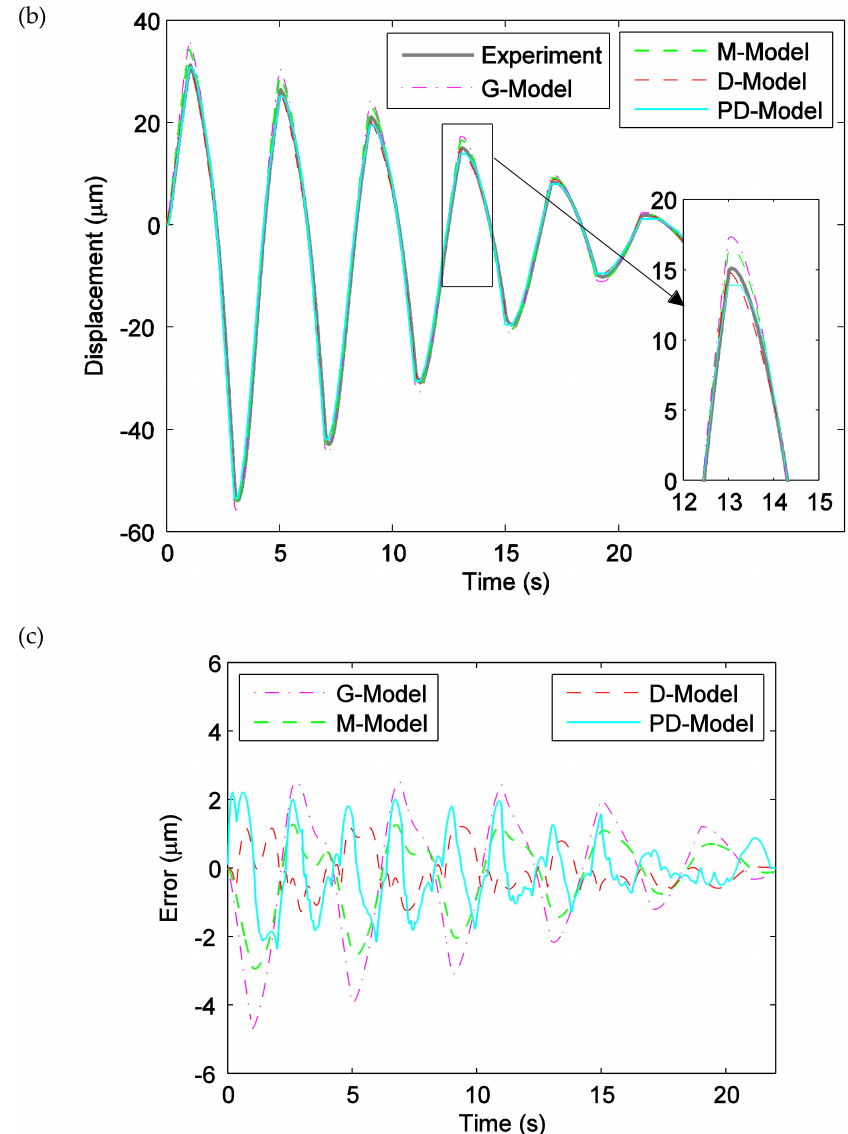
Figure 12. Comparison of experimental data and the predicted results of the established ISSF-Duhem model and the PD-Model when the magnetostrictive actuator under the triangle excitation current with various amplitudes: ( a ) the displacement versus current, ( b ) the displacement versus time, and ( c ) the error versus time. G-Model: the ISSF-Duhem model with Grompertz function-based shape function; M-Model: the ISSF-Duhem model with modified hyperbolic tangent function-based shape function; D-Model: the ISSF-Duhem model with a one-sided dead-zone operator-based shape function; PD-Model: the modified Prandtl–Ishlinskii model with a one-sided dead-zone